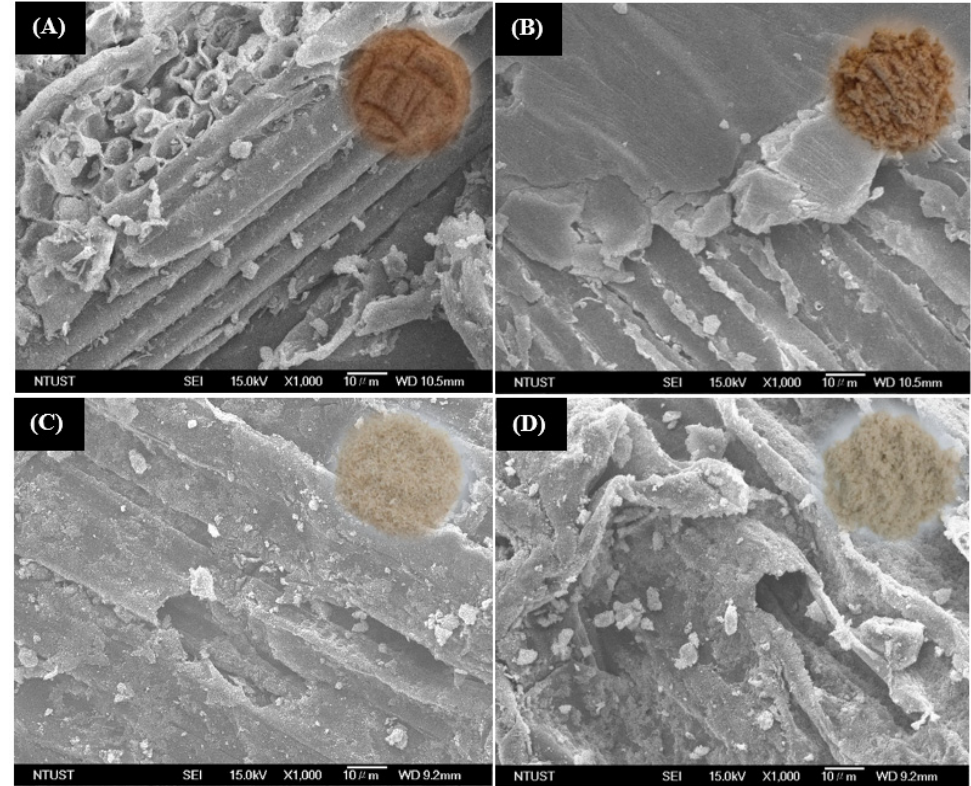
Figure 1. Morphology images of rice husk (RH) ( A ) before and ( B ) after delignification (RH-D), and sugarcane bagasse ( C ) before (SB) and ( D ) after delignification (SB-D). sugarcane bagasse ( C ) before (SB) and ( D ) after delignification